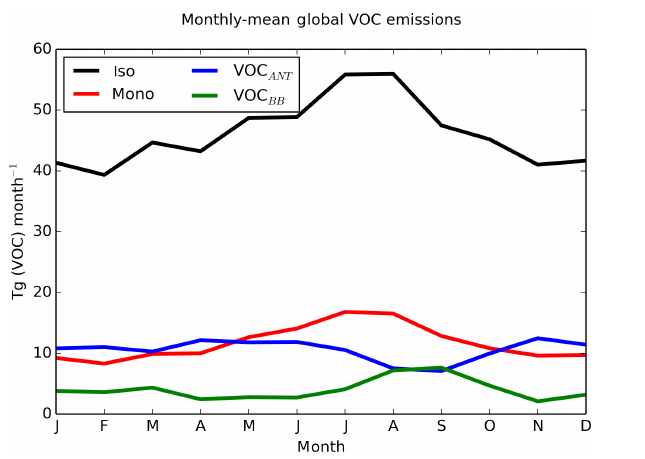
Figure 2. Seasonality of global SOA precursor emissions from the different VOC sources: monoterpene (red), isoprene (black), VOC ANT (blue), and VOC BB (green) (Tg (VOC) month − 1 ). Table 1. Reaction kinetics for SOA precursors in UKCA.